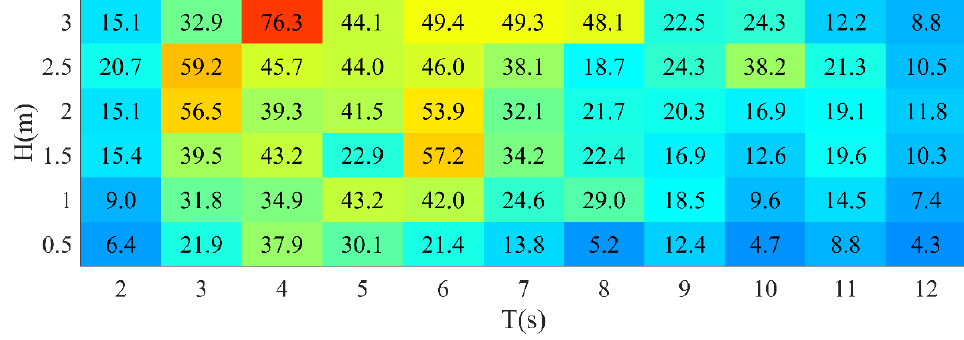
Table 4. Average power generation efficiency.